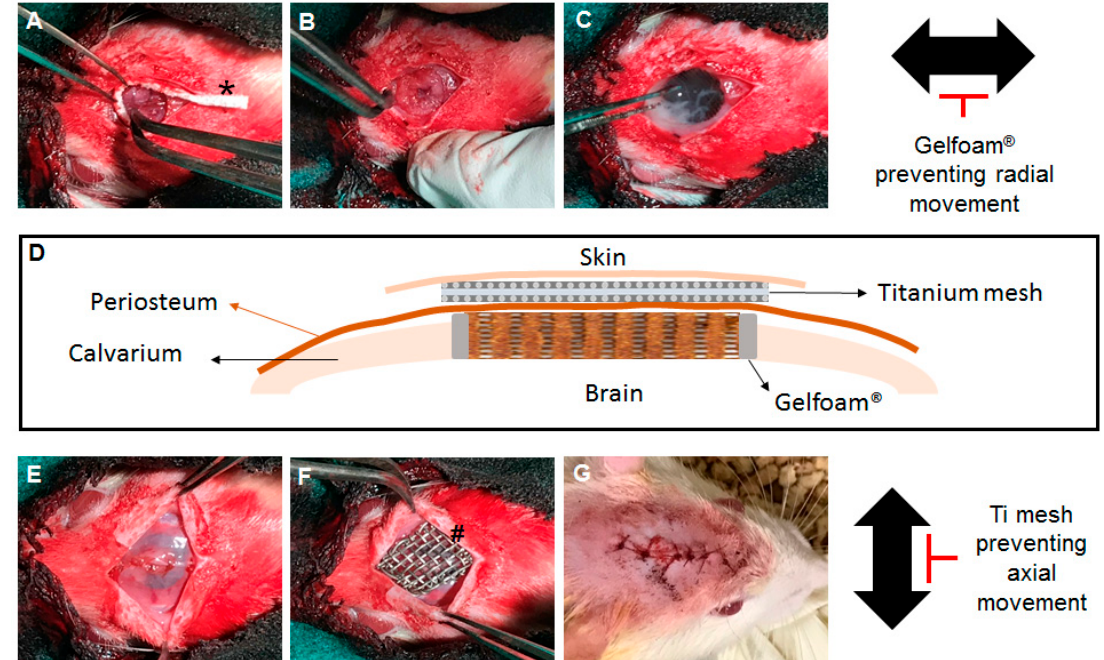
Figure 1. Surgical procedure of scaffold implantation into critical-sized defect on rat calvaria. Gelfoam (#) was implanted on the sutured periosteum.